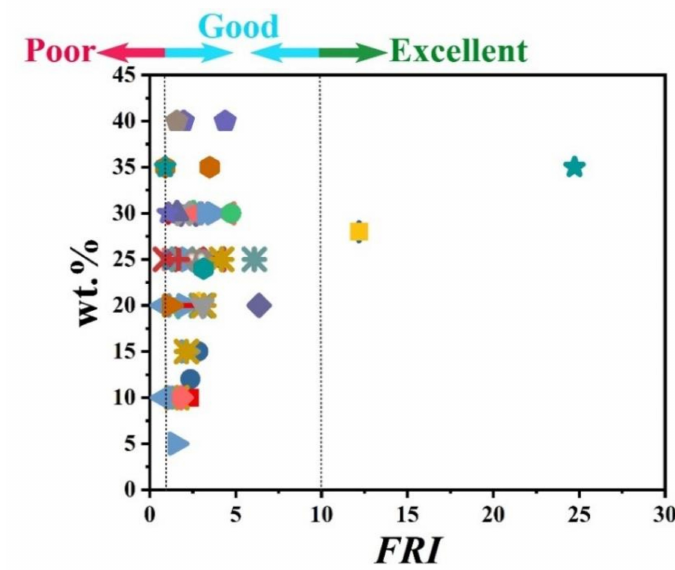
Figure 1. Flame Retardancy Index ( FRI ) values as a function of phosphorus flame retardant (FR) type and content. Symbols are indicative of di ff erent types of phosphorus flame retardant used. Here: